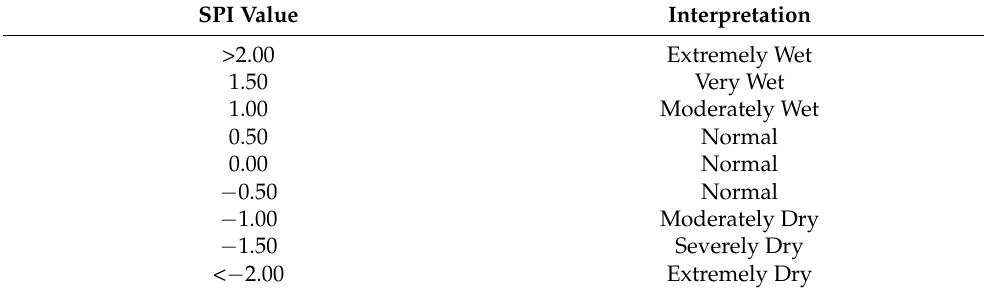
Table 1. Standardized precipitation index